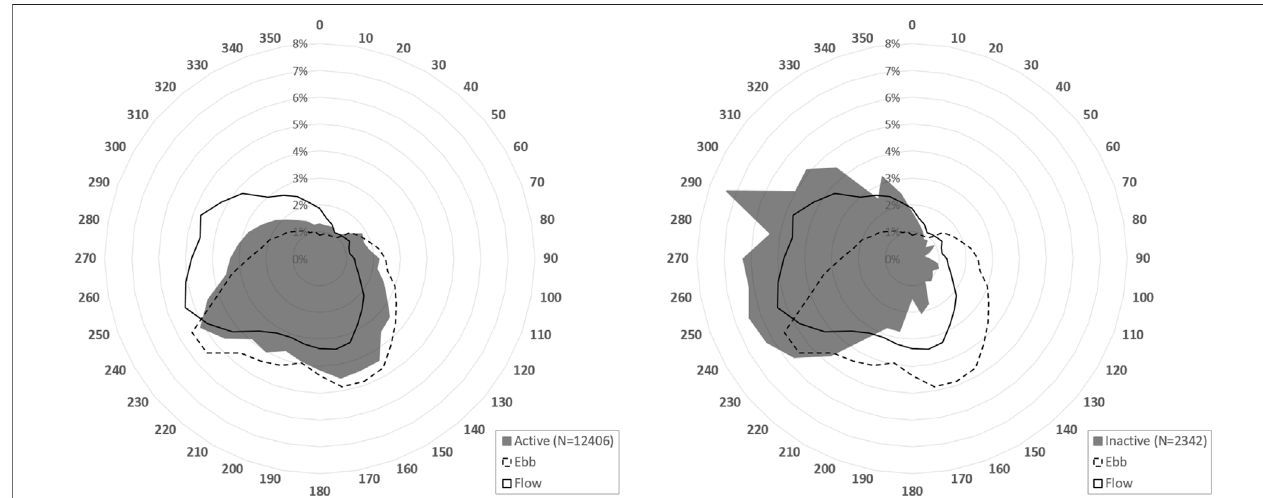
FIGURE 7 | Rose diagrams showing the distribution of bottom current fl ow directions at water depths from 1,234 m to 1,242 m during active (left diagram) and inactive(rightdiagram)gasemissions,andduringebband fl owtides(bothdiagrams).Currentdirectionsduringactiveventinglargelyre fl ectcurrentdirectionsduringebb tides. Times when gas emissions were inactive are strongly linked with predominantly westward ( fl owing towards west)